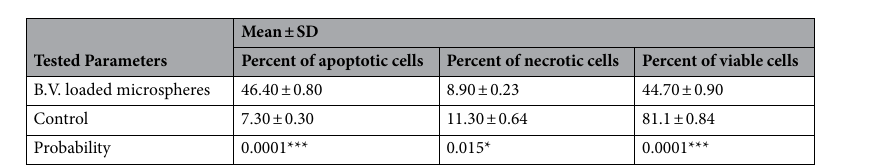
Table 5. The distribution of necrotic, apoptotic and living cells incubated with IC 50 concentrations of B.V. loaded cross-linked chitosan coated microspheres for 24 h. *P < 0.05, **P < 0.01 and ***P < 0.001 show the significance of difference between mean viability of untreated (control) and treated (experimental)